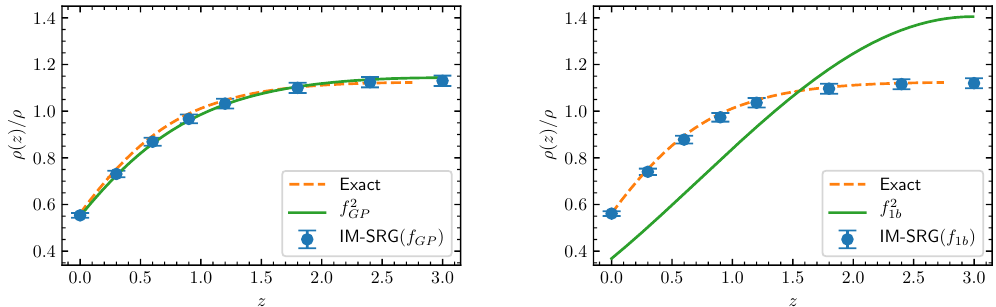
Figure 3: Density of the Bose gas in the frame co-moving with the impurity. The dots are calculated with the flow equations. Left [ right ] panel shows the results of the IM- SRG( f ) [ IM-SRG( f ) ] method. The densities obtained directly from the reference GP 1 b [ f ] are given by the solid green curves. The exact pair-correlation function state f GP 1 b from Ref. [ 42 ] is shown as a dashed orange curve. Our results are presented for N = 6 bosons plus a single impurity atom. The interaction strengths are c = γ = 1, and the masses of impurity and bosons are